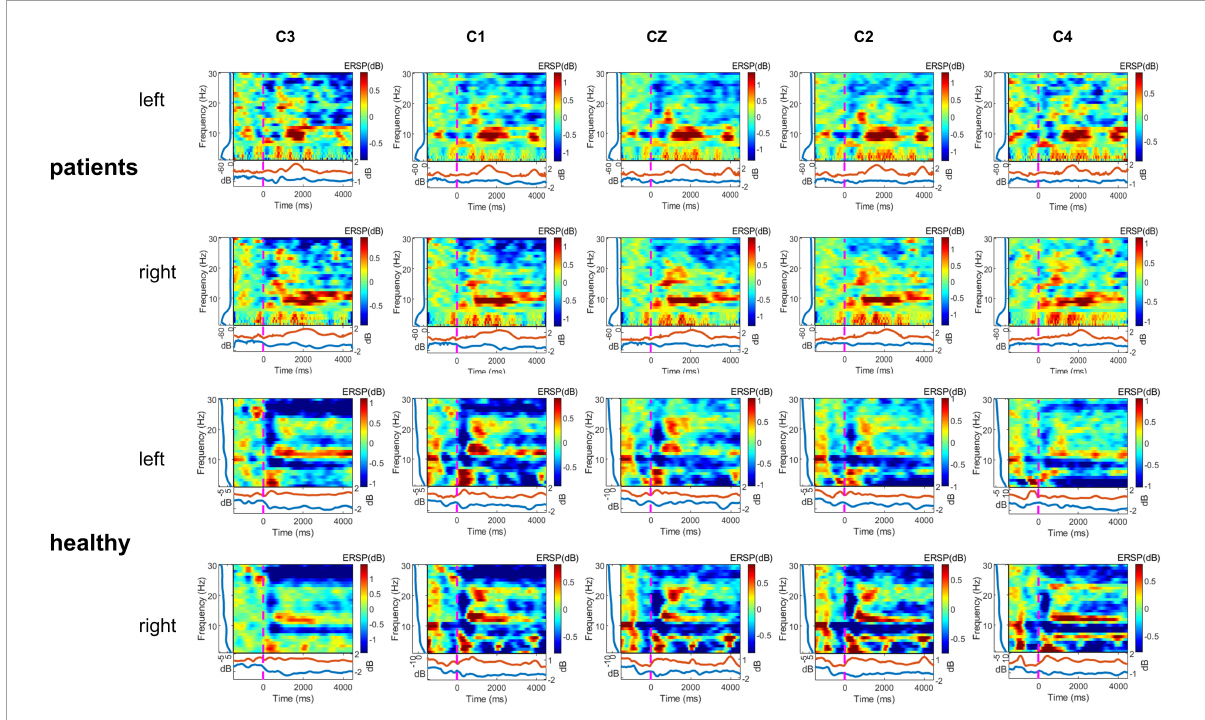
FIGURE3 Time—frequency maps displaying significant event-related desynchronization (ERD) (blue) and event-related synchronization (ERS) (red), two motor imagery (MI) (left and right) task, two group (lower limb amputees and healthy controls), and five channels (C3, C1, Cz, C2, C4). Maps displaying group averaged power (ERD, ERS) in the 1–30 Hz band during two motor imagery tasks (second –2 to 5 s of the trial). Left, left-side MI task; right, right-side MI